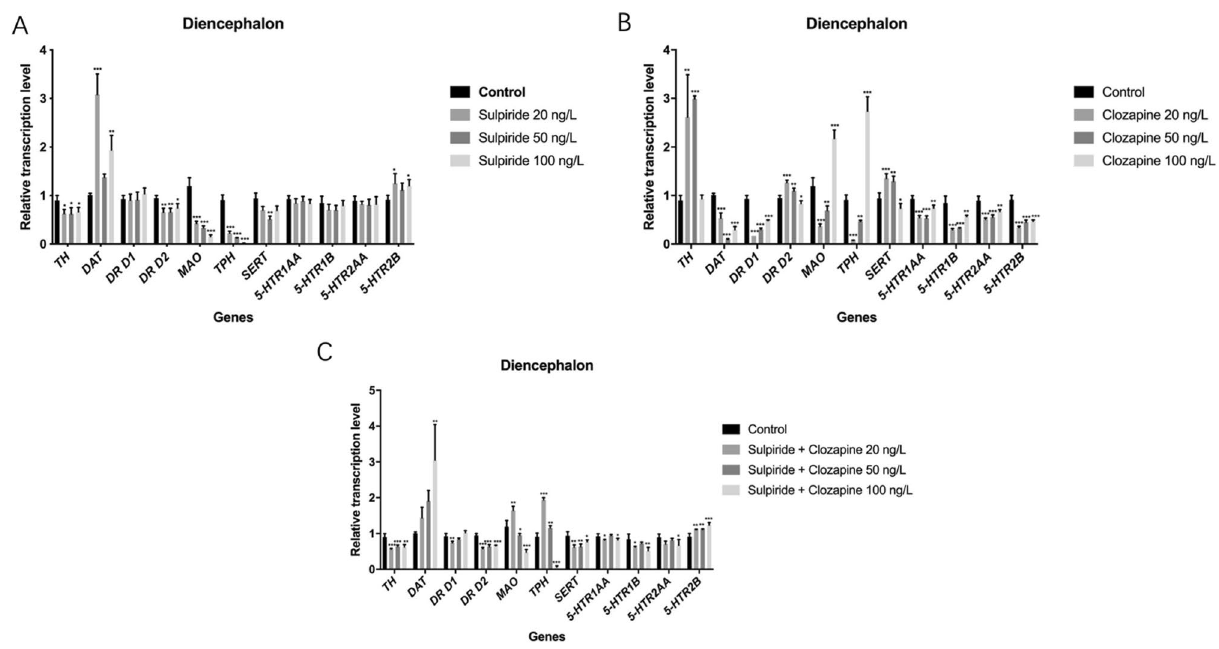
Figure 4. Changes in the mRNA levels of functional molecules involved in DAergic and 5-HTergic systems in zebrafish diencephalon induced by sulpiride and clozapine. Note: ( A ) Sulpiride, ( B ) Clozapine, ( C ) Mixture of sulpiride and clozapine. Data are presented as means ± SE (n = 10). p < 0.05 was considered statistically significant. * p < 0.05, ** p < 0.01, *** p <